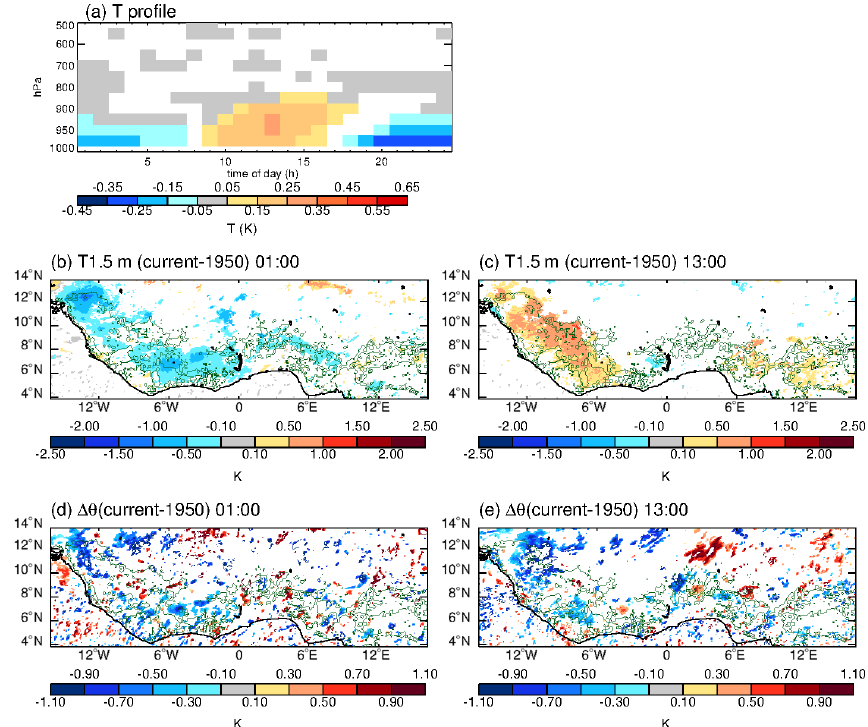
Figure 5. Changes in diagnostics for (a) diurnal cycle of temperature profile averaged over all deforested pixels and for night (01:00UTC) (left) and day (13:00UTC) (right): (b) and (c) near-surface temperature and (d) and (e) (cid:49)θ defined as θ e at 925hPa minus θ es at 700hPa. Insignificant changes are shown in white (for (cid:49)θ this is the individual pixel significance, whereas for T 1.5m, FDR correction has been applied), whereas small but significant changes either side of zero are shown in grey. Green contours show where there has been